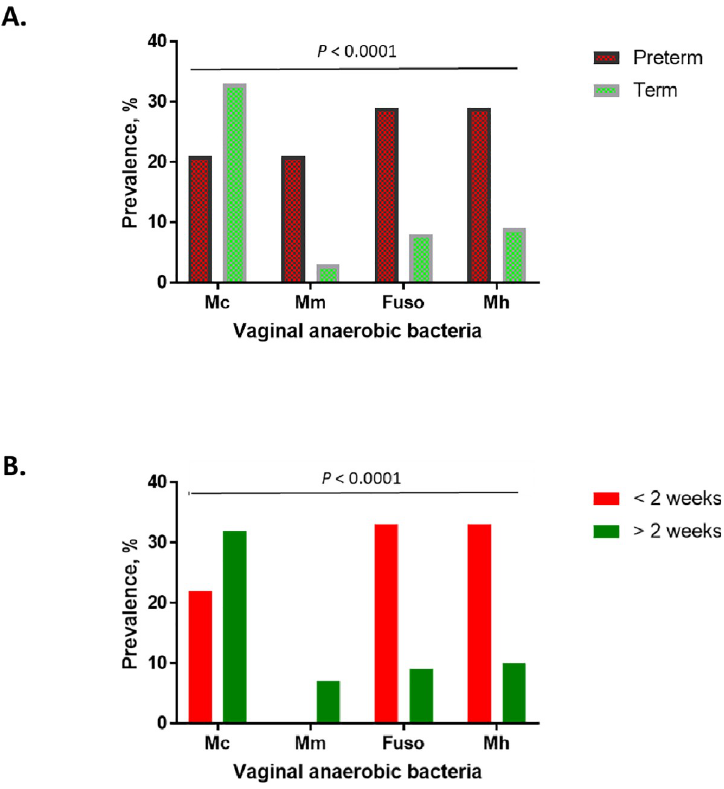
Fig 1. Prevalence of vaginal mixed anaerobic bacterial species in relation to delivery outcome. (A) Preterm vs. term. The preterm-delivered women had higher prevalence of Fusobacterium sp. (Fuso), Mubiluncus mulieris (Mm), Mycoplasma hominis (Mh), whereas Mubiluncus curtisii (Mc) was more prevalent in term-delivered women though to a lesser proportion. (B) Delivery within and after 2 weeks. Fusobacterium sp. and M . hominis were more prevalent in women who delivered within 2 weeks of sampling, whereas M . curtisii and M . mulieris were more prevalent in women that delivered later than 2 weeks of sampling.